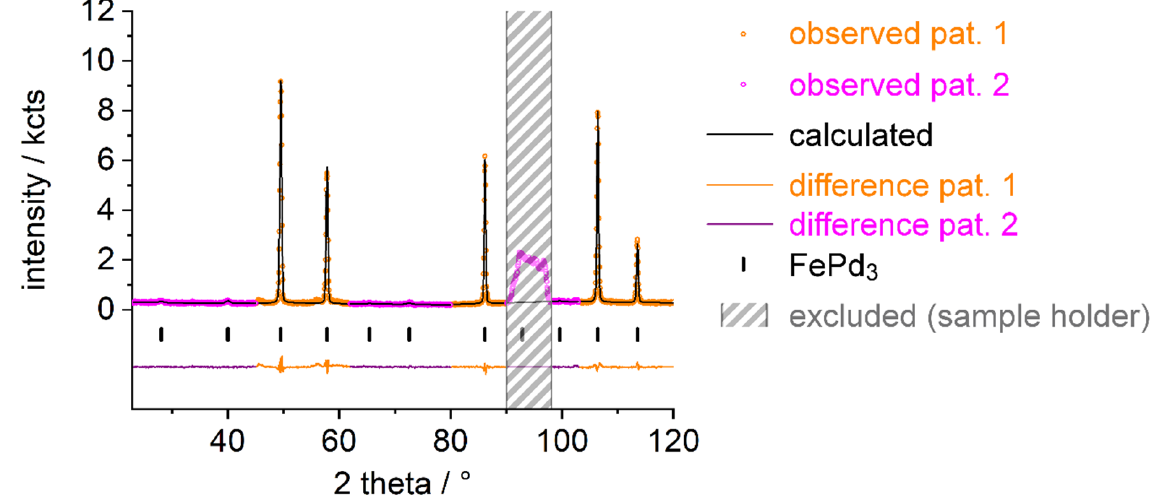
Figure A23. Rietveld refinement of the crystal structure of FePd 3 D 0.064(10) (for details, see eleventh row in Tables A8 and A9) based on neutron powder diffraction data (NUMOR 131815 [21], λ =186.80(2) pm, D20 ILL, Grenoble) in a single-crystal sapphire cell at 539(1) K and 8.29(1 ) MPa deuterium pressure using FullProf [24].